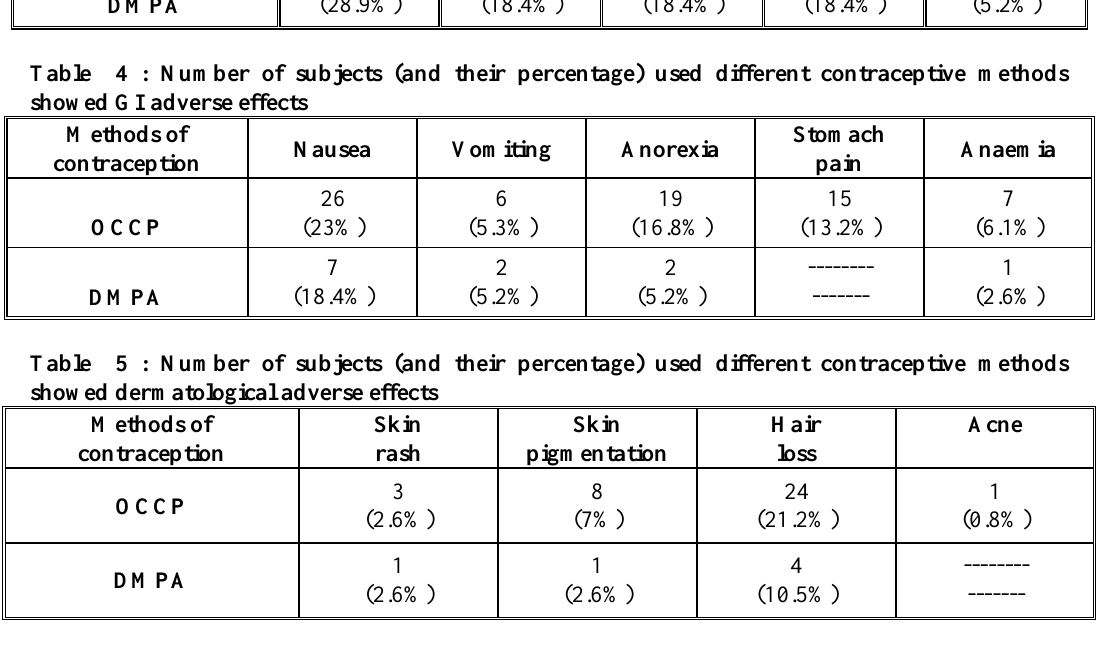
Table 6 : Number of subjects (and their percentage) used different contraceptive methods showed other adverse effects Methods